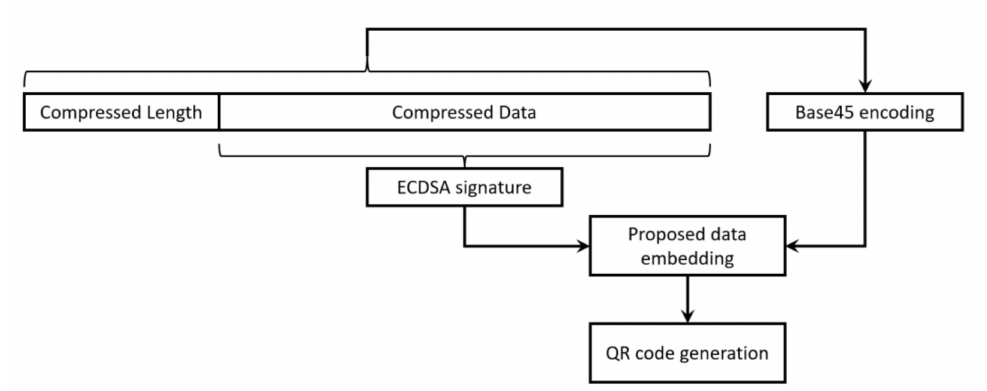
Figure 2. The data flow for the Quick Response (QR) code